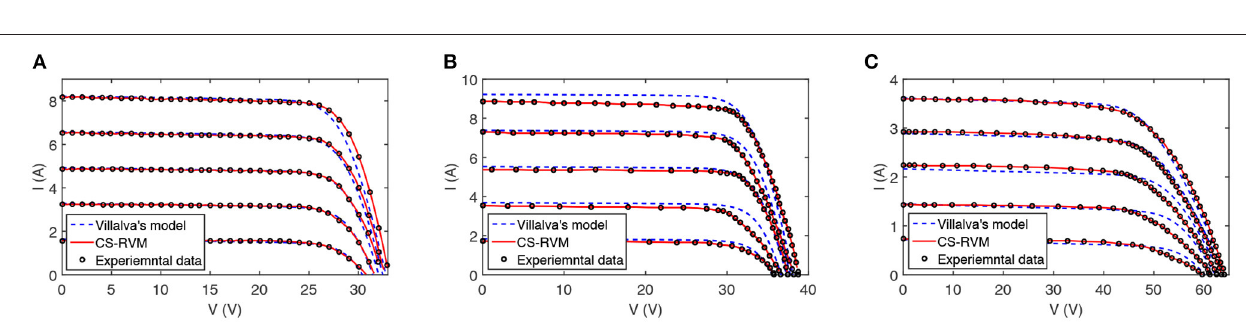
FIGURE 5 | Median of the RMSE values along the number of function evaluations in the 50 runs of different models (A) BPNN, (B) RBFNN, (C) SVM, (D) Villalva’s model, (E) RVM, and (F) CS-RVM.